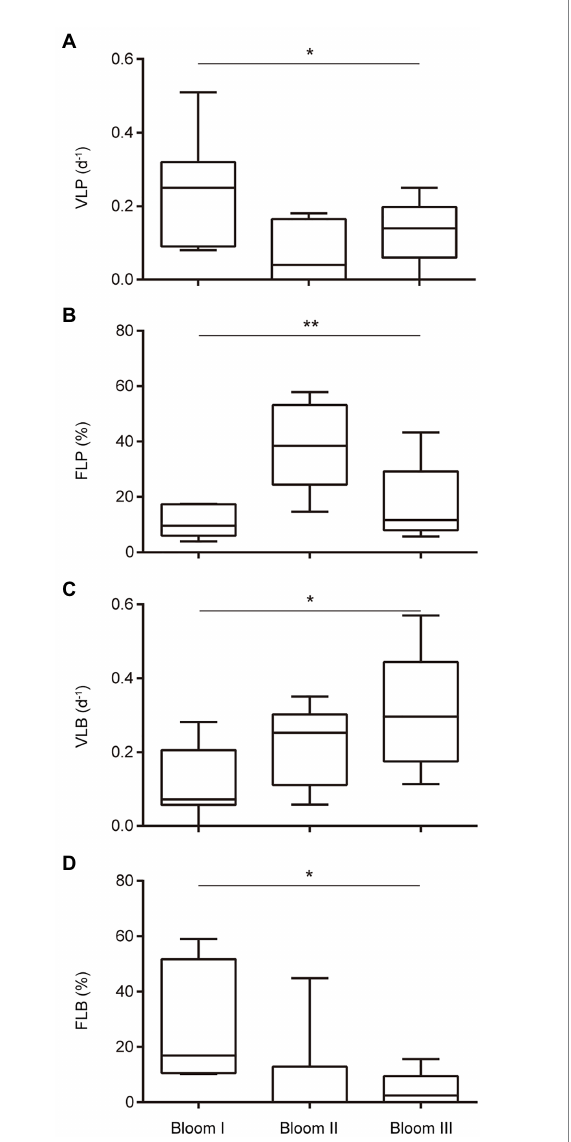
FIGURE 4 Boxplot of the viral-induced lysis rate of phytoplankton (VLP) (A) , viral-induced lysis rate of bacterioplankton (VLB) (C) , frequency of lysogenic phytoplankton (FLP) (B) , and frequency of lysogenic bacterioplankton (FLB) (D) in three bloom stages. * and ** indicate significant differences among the three stages at p < 0.05 and p < 0.01,